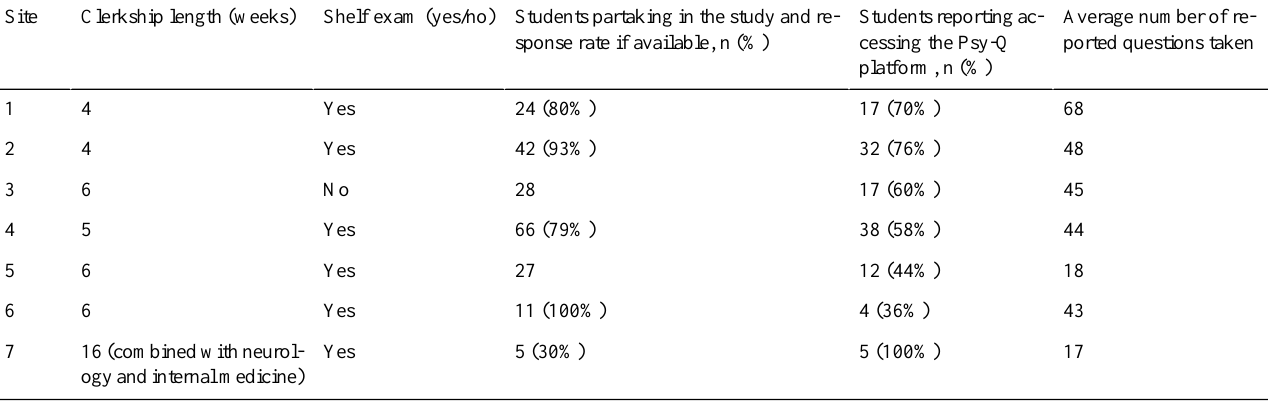
Table 1. Data from the seven study sites, their engagement with the survey, and reported use of the Psy-Q platform.